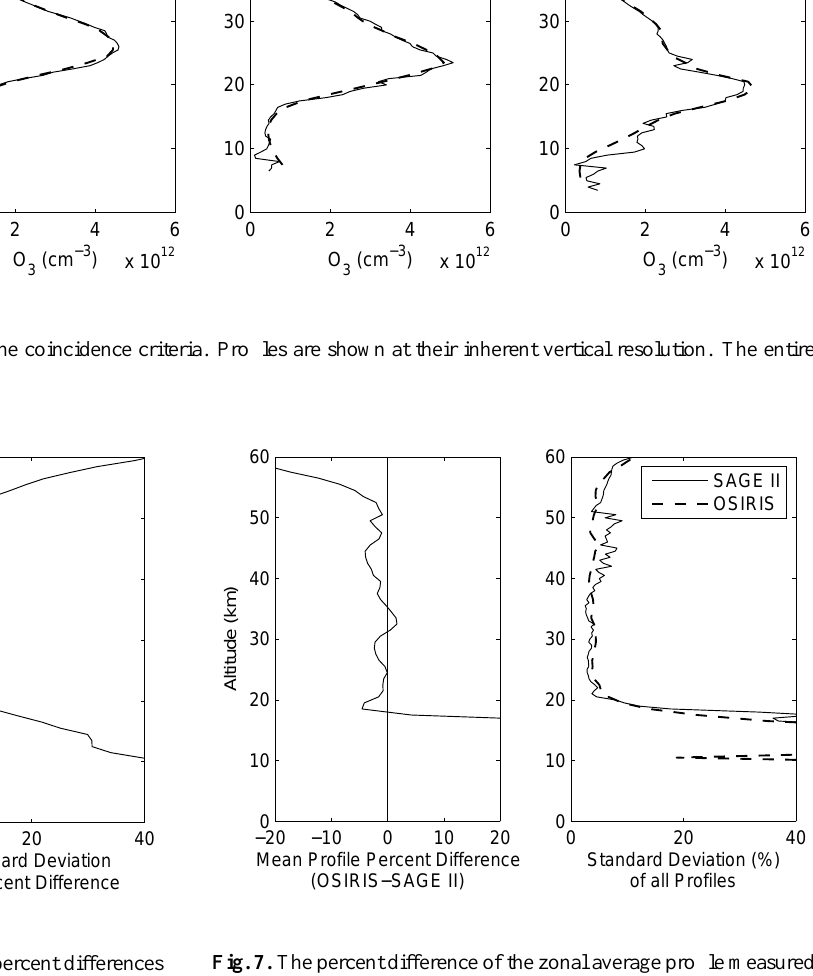
Fig. 6. The mean and standard deviation of the percent differences between the retrieved ozone profiles for 196 coincident OSIRIS and SAGE II measurements.